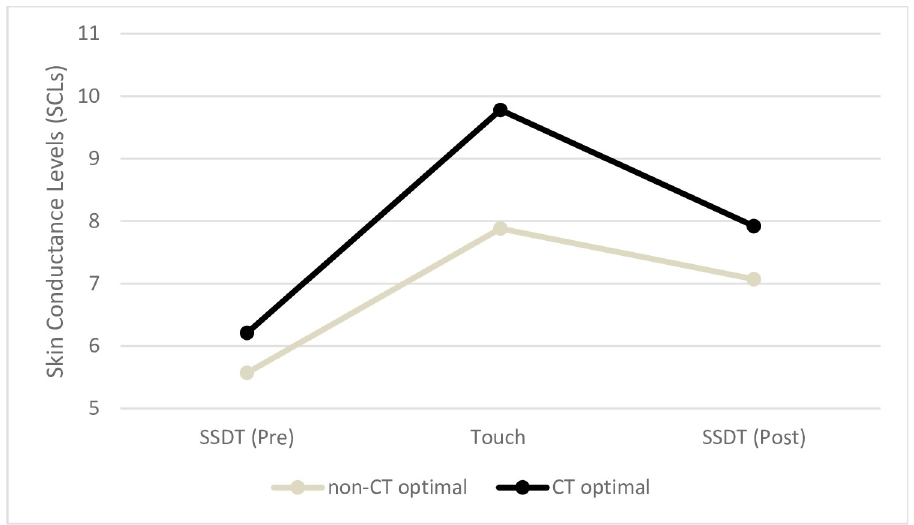
Fig 6. SCLs in the CT optimal and in the non-CT optimal groups during the first repetition of the SSDT (SSDT Pre), the touch manipulation (Touch), and the second repetition of the SSDT (SSDT Post). SCLs increased during the touch manipulation, especially for the CT optimal